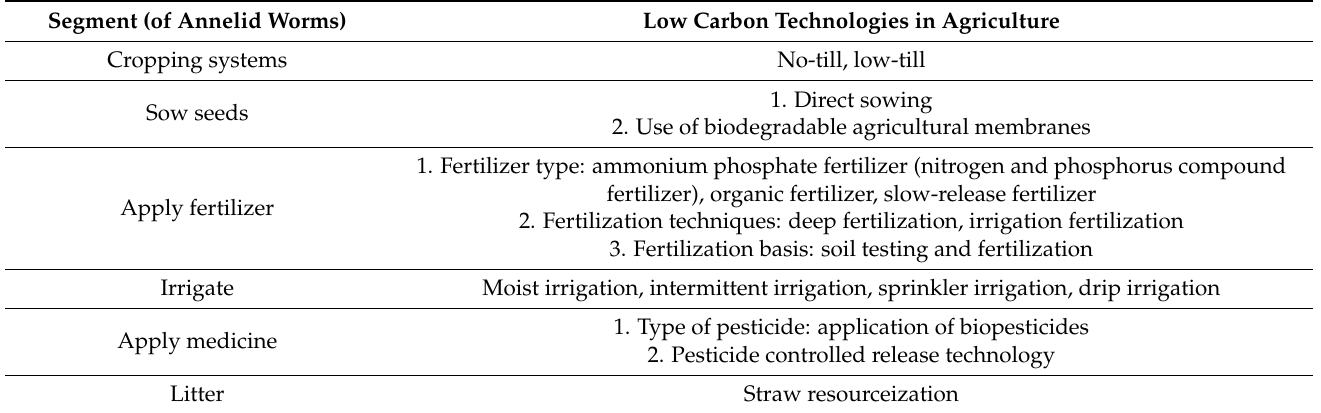
Table 3. Classification of low carbon technology dimensions in